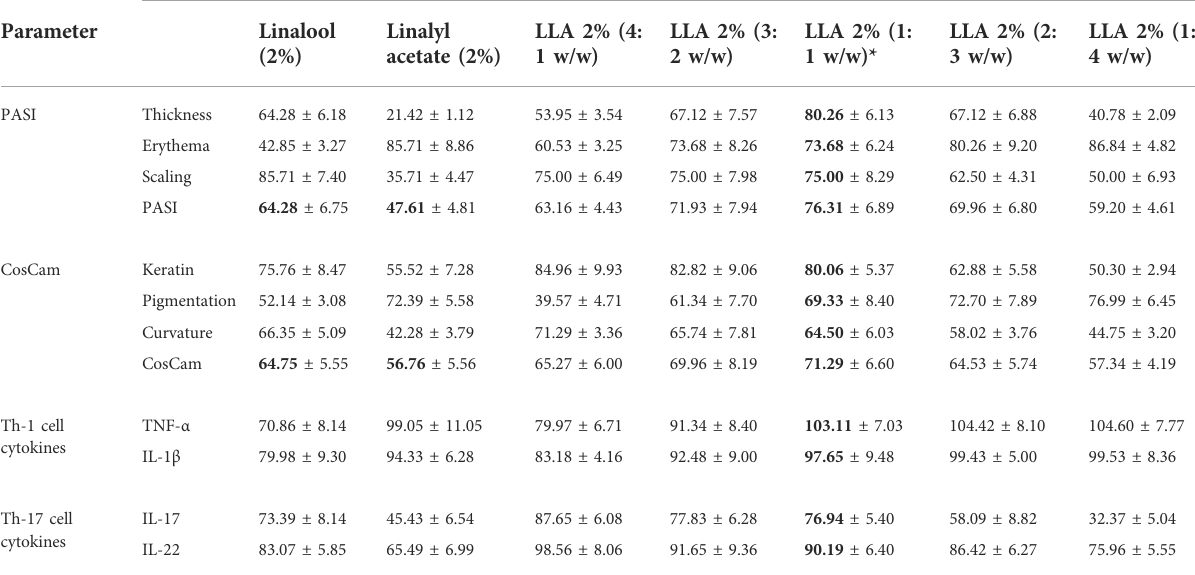
TABLE 1 Anti-psoriatic effect of linalool (L) and linalyl acetate (LA) combinations.